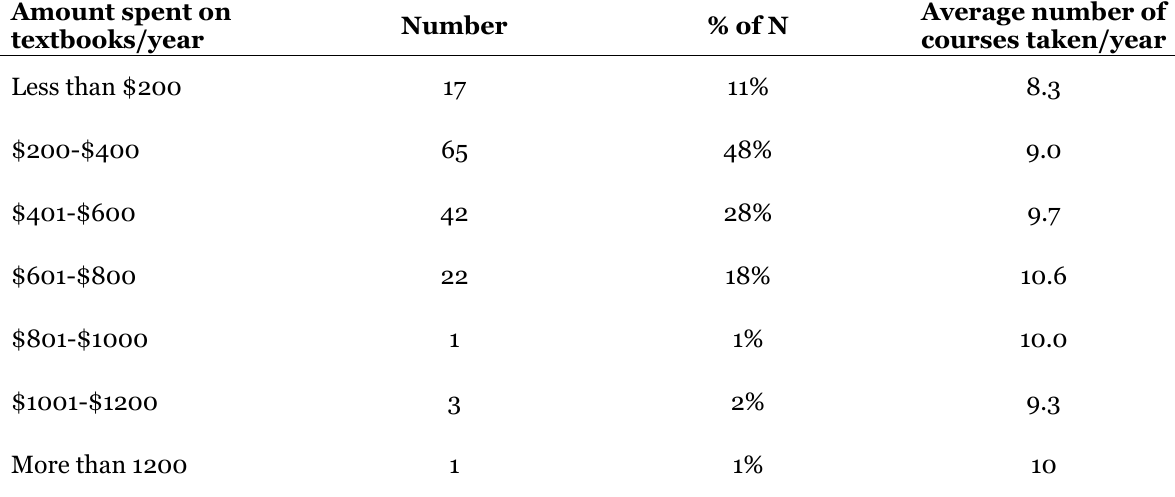
Reported Amount Spent on Textbooks and Average Courses Taken per Academic Year (Fall, Spring, and Summer Terms Combined ) Amount spent on